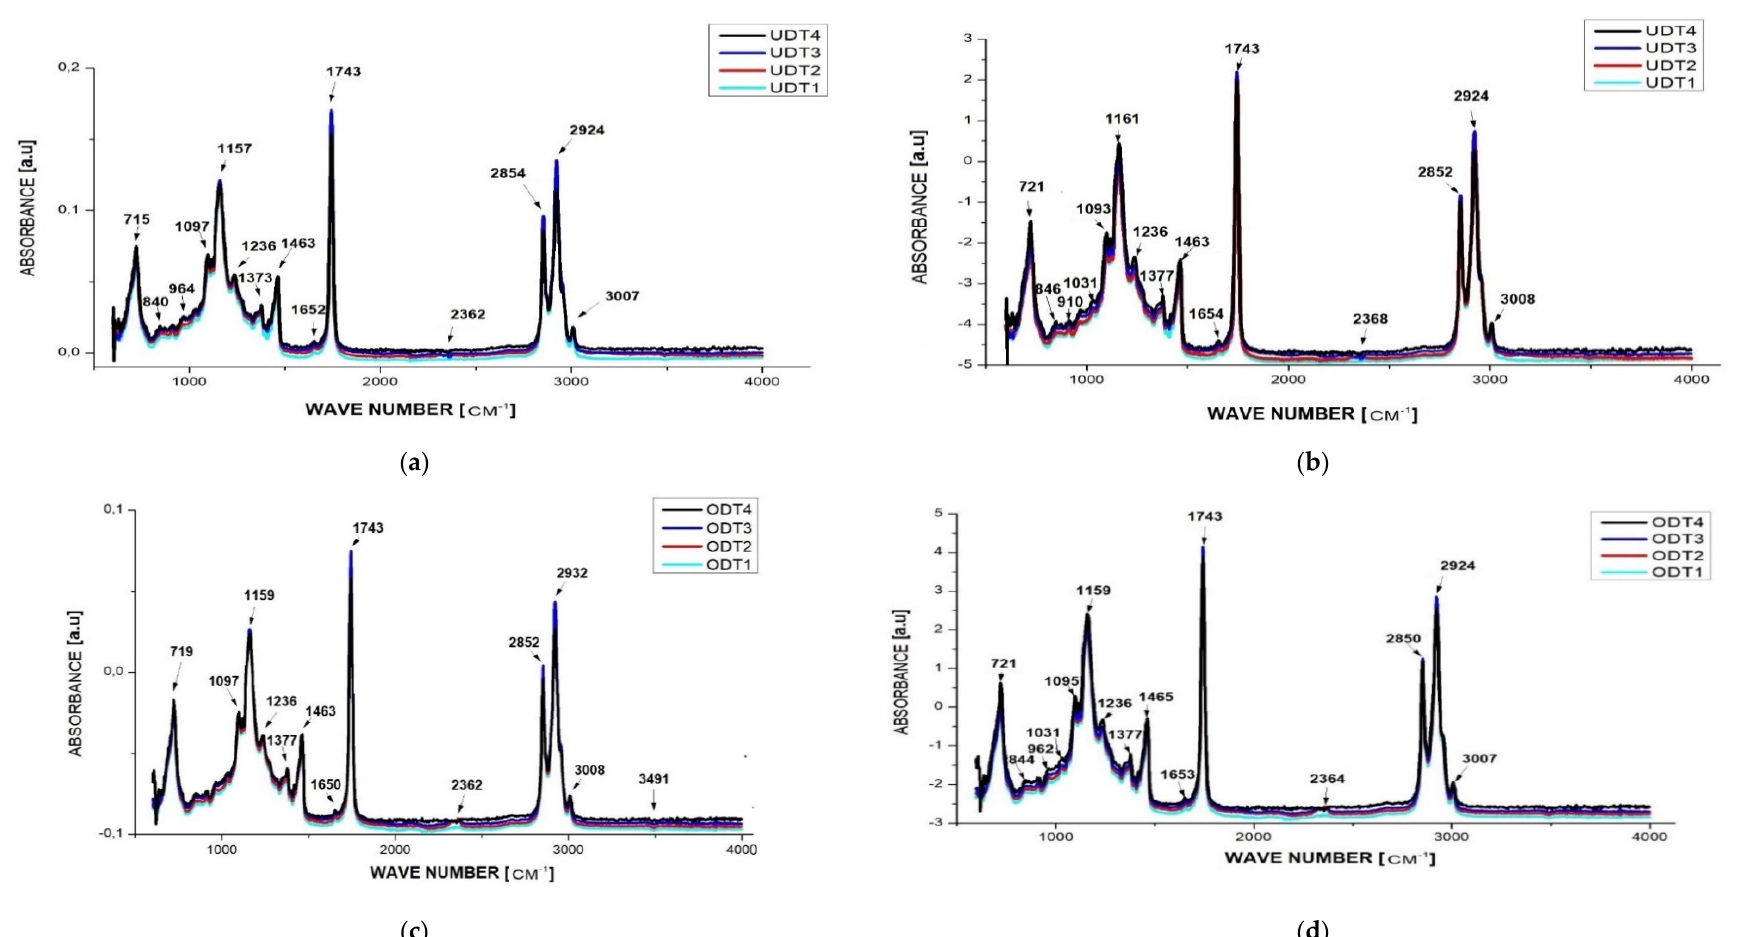
Figure 3. FTIR spectra of pumpkin seed oil (UD) and oleogel (OD) at fresh (T1), and stored one month (T1), five (T2) and eight months (T4) at room temperature: